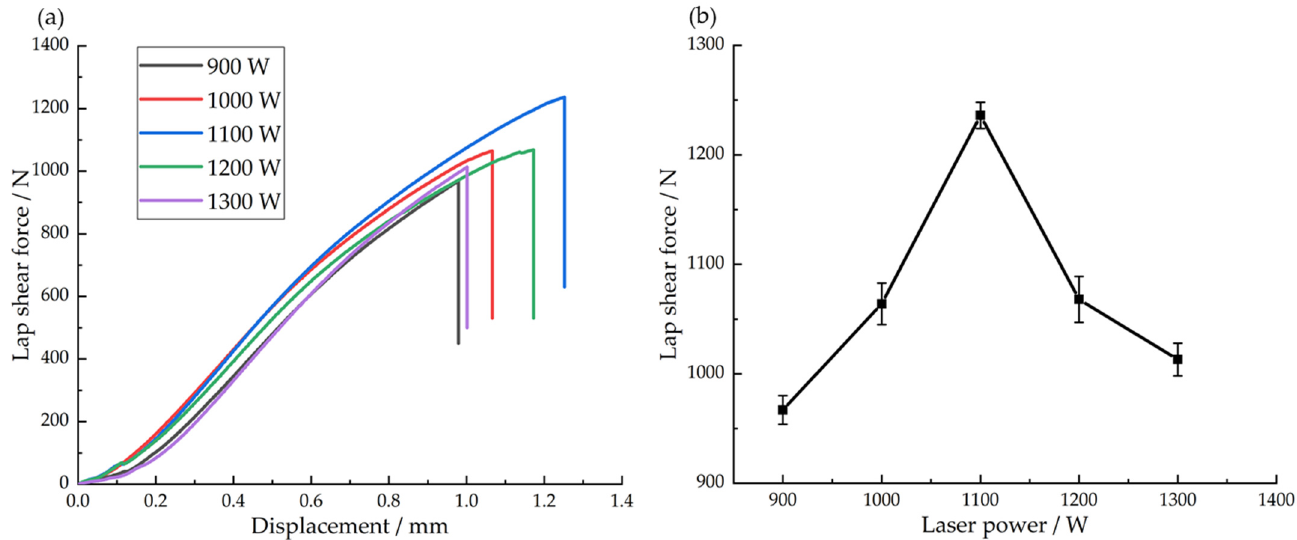
Figure 7. Effect of laser power on lap tensile shear force: ( a ) Representative lap tensile shear testing under different laser powers; ( b ) Mean value of lap tensile resistance under different laser powers.